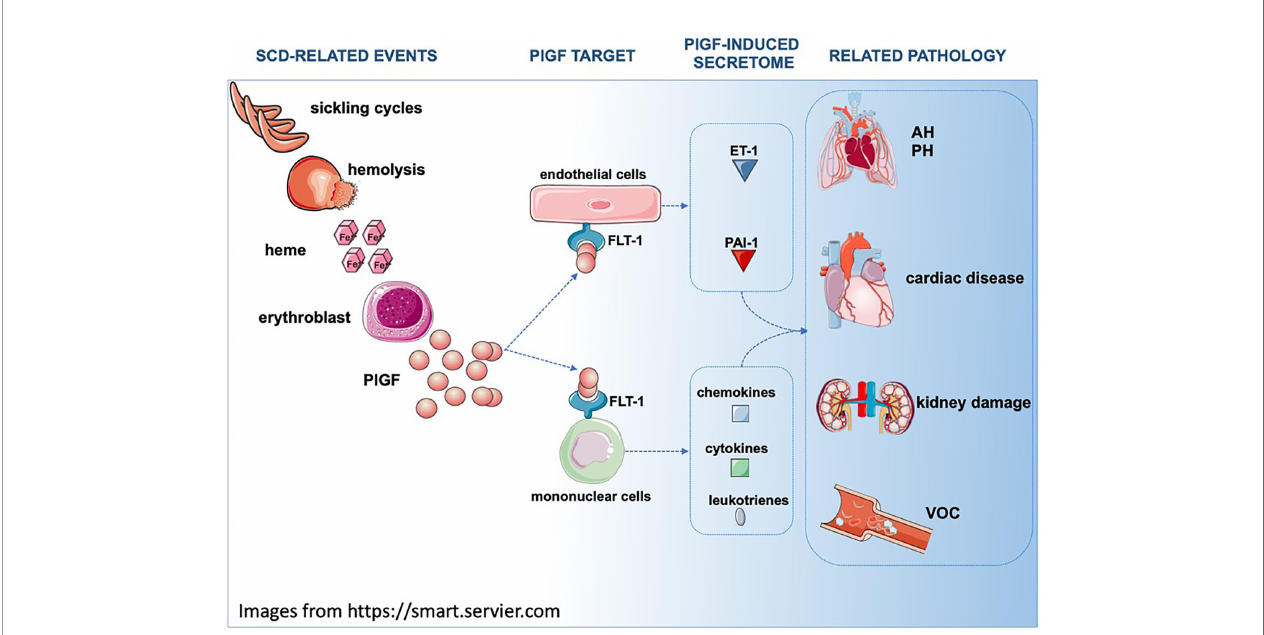
FIGURE 2 | In SCD, repeating sickling cycles result in increased hemolysis. Hemolysis byproducts such as heme induce PlGF expression in multiple cell types (for simplicity purposes only erythroblasts are depicted). Secreted PlGF is a ligand for FLT-1 receptor and triggers the expression of ET-1, PAI-1, leukotrienes and cytochemokines, affecting the physiology of multiple organs. AH, Airway hyperreactivity; PH, Pulmonary hypertension; FLT1/VEGFR1, Fms related receptor tyrosine kinase 1; PlGF, placenta growth factor; ET-1, endothelin 1; PAI-1/Serpine1, plasminogen activator inhibitor